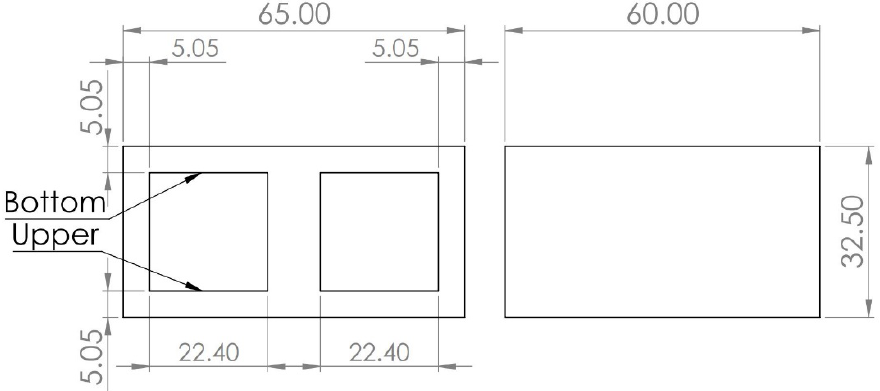
Figure 2. Test casting scheme.